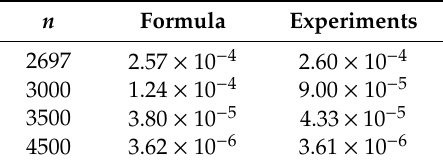
Table 8. Probability that the OOV algorithm will incorrectly estimate one-bit of the noise vector whose weight is incorrectly estimated as 77.